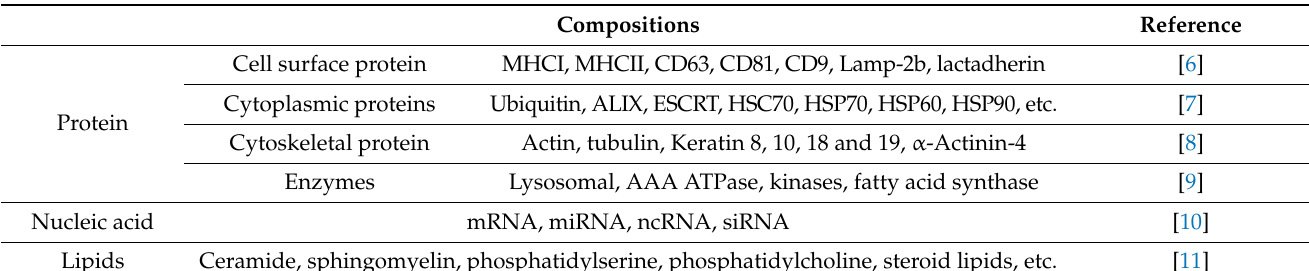
Table 1. Summary of the exosome